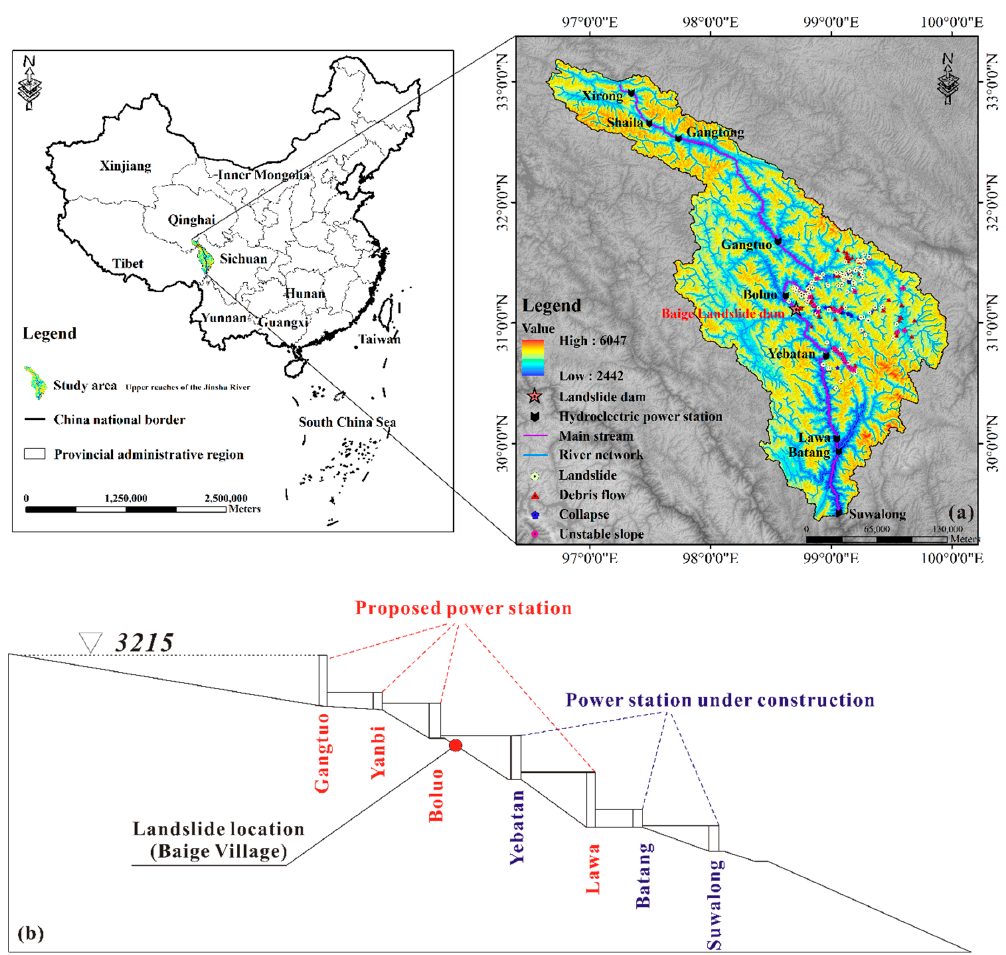
Figure 1. Plane distribution map of hydropower stations on the upper reaches of the Jinsha River ( a ) and distribution map of hydropower stations in the longitudinal section of the river channel ( b ).